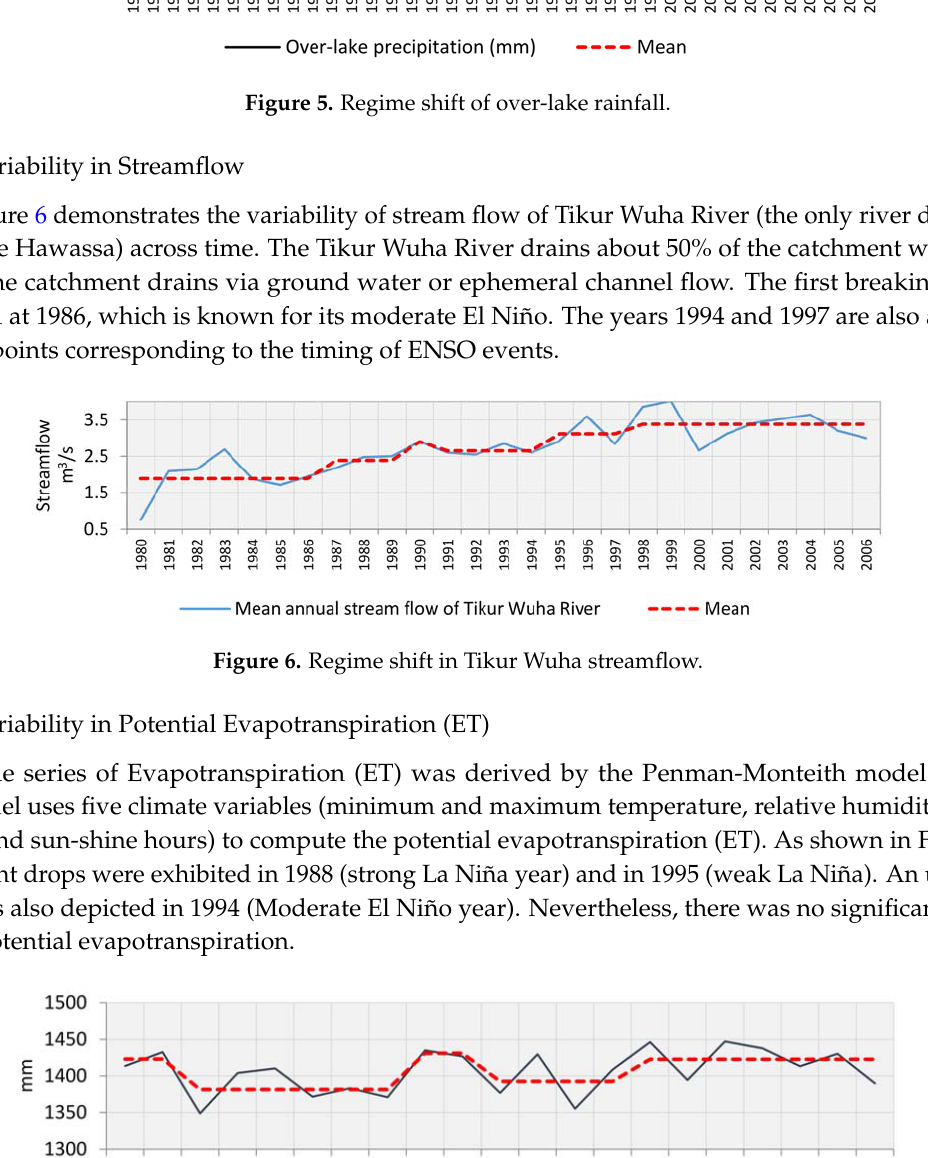
Figure 7. Regime shifts in potential evaporation as computed by the Penman-Monteith model.